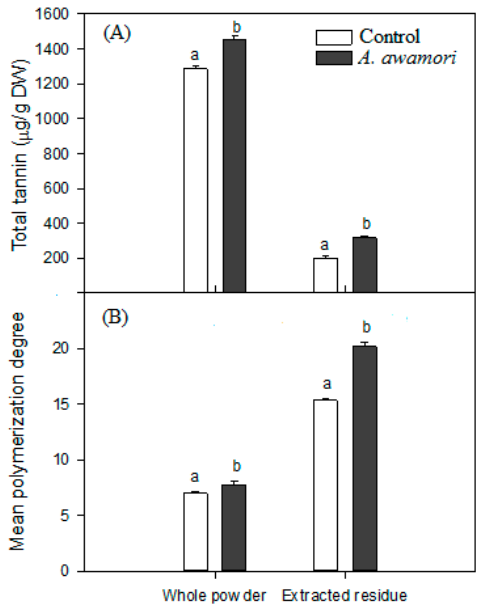
Figure 3. The changes in total tannin content ( A ) and the mean polymerization degree ( B ) present in litchi pericarp powder and the extracted residue after the A. awamori treatment. Data marked with the same letter above columns were not significant difference at p < 0.05 (mean ± SD, n = 3).